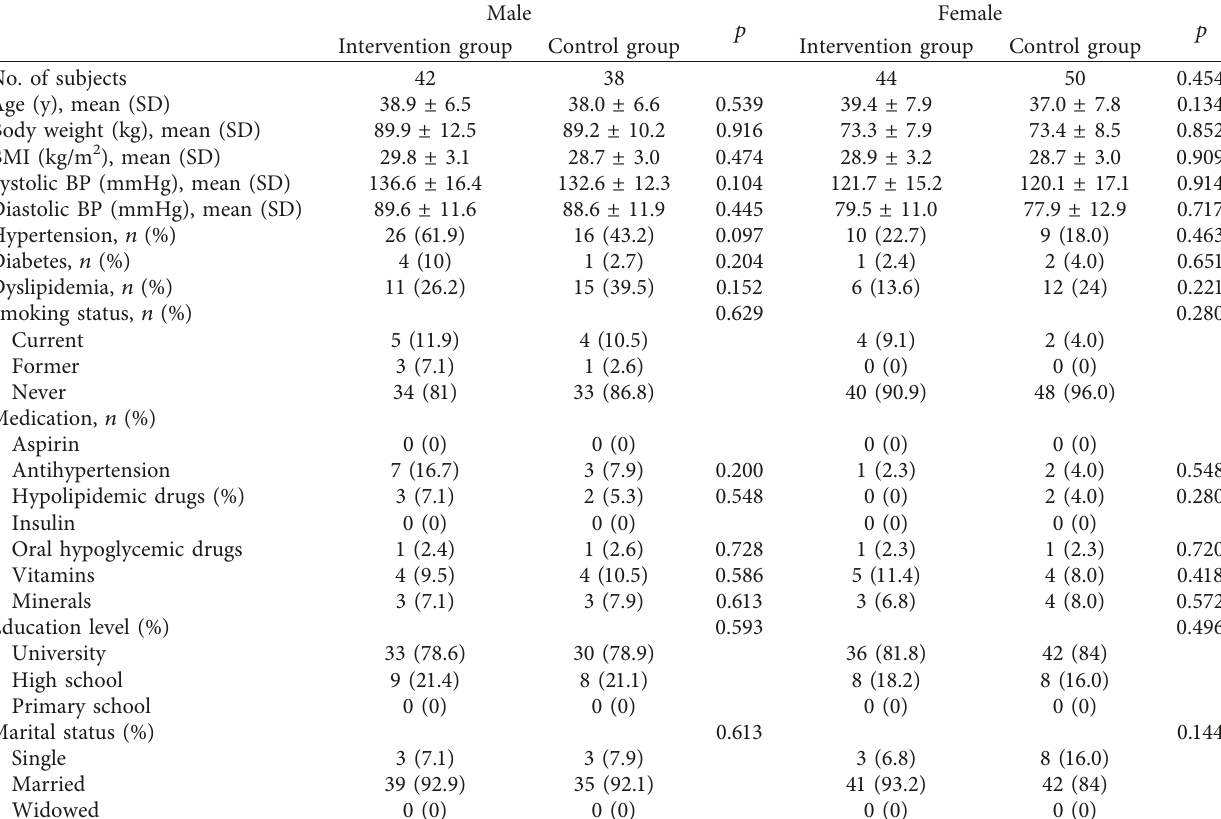
Table 1: Characteristics of participants at